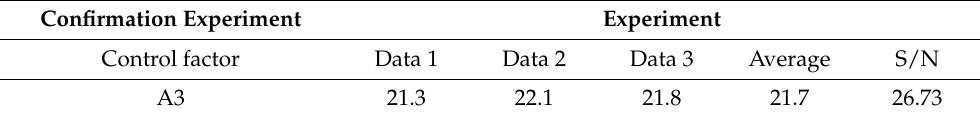
Table 22. The confirmation experiment of the far-infrared temperature rise.